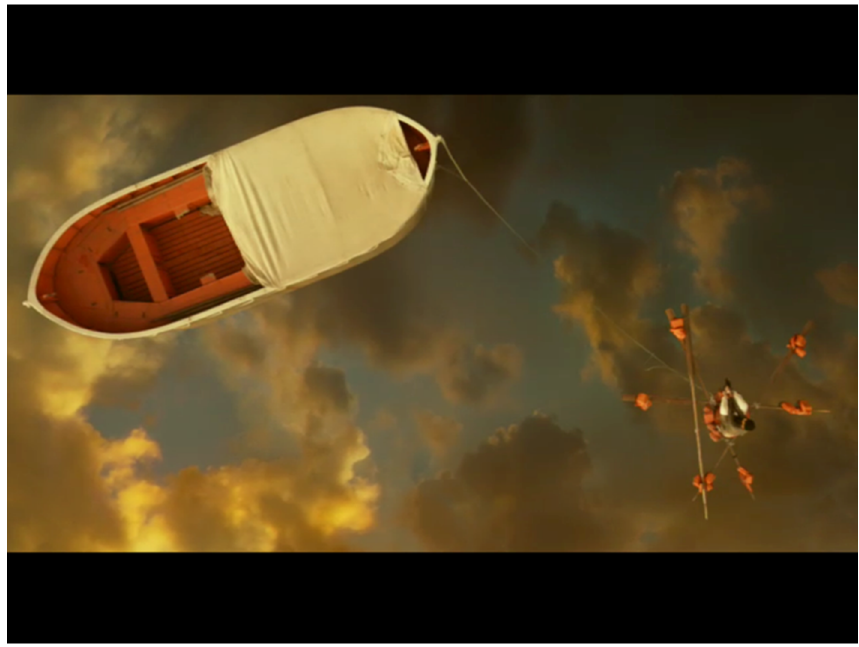
Figure 14. Pi sits on a digitally rendered ocean, reflecting a digitally ‐ rendered sky.